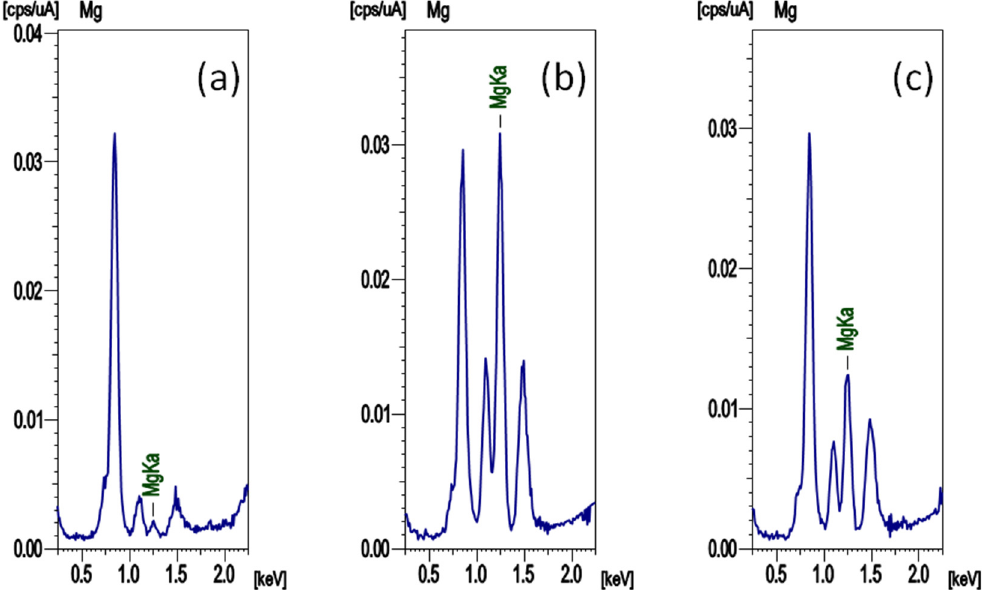
Figure 5. X-ray fluorescence spectra of the surface of the working electrode of the cell ( a ) before applying a current, ( b ) after applying a current of − 50 μ A for 36 h, and ( c ) applying a current of +50 μ A for 36 h after ( b ).